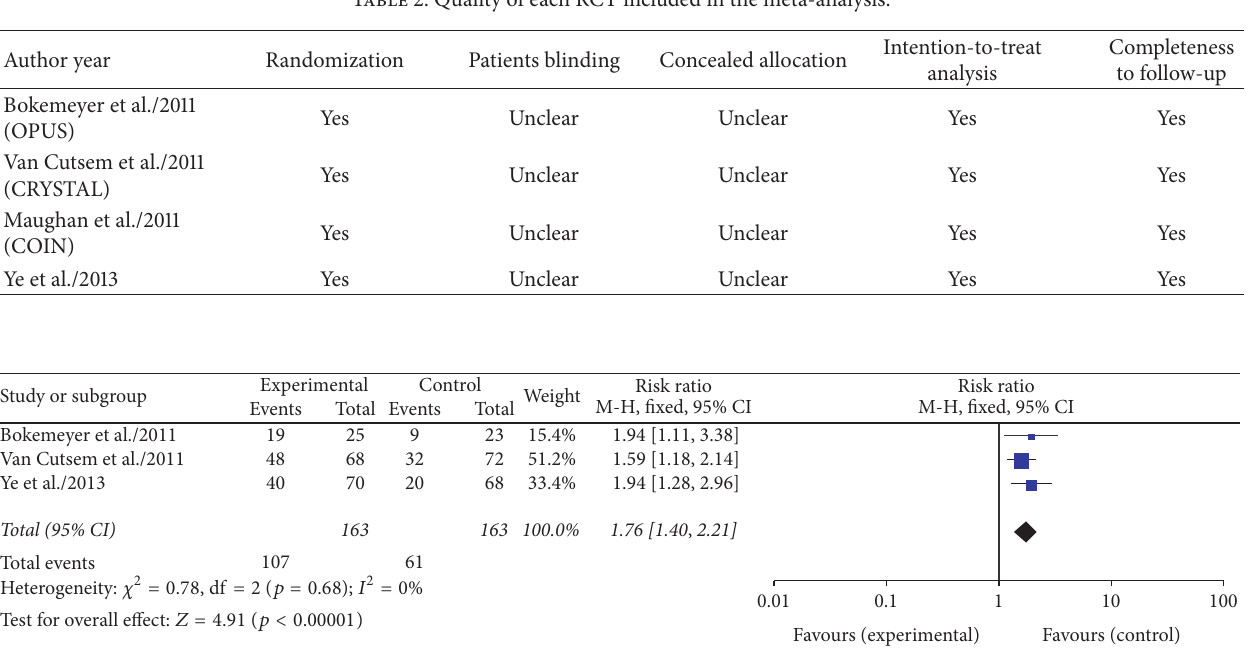
Hazard ratio IV, fixed, 95%